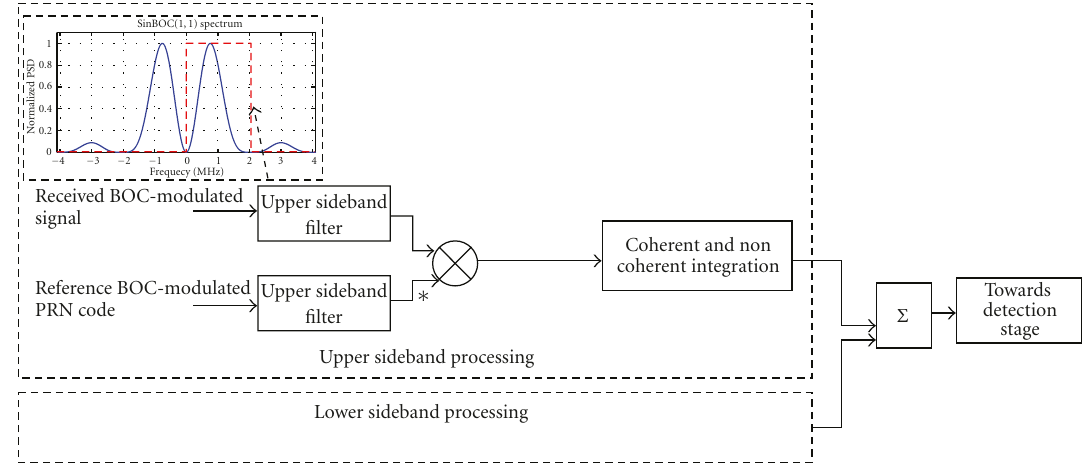
Figure 2: Block diagram of B&F method, single-sideband processing (here, upper